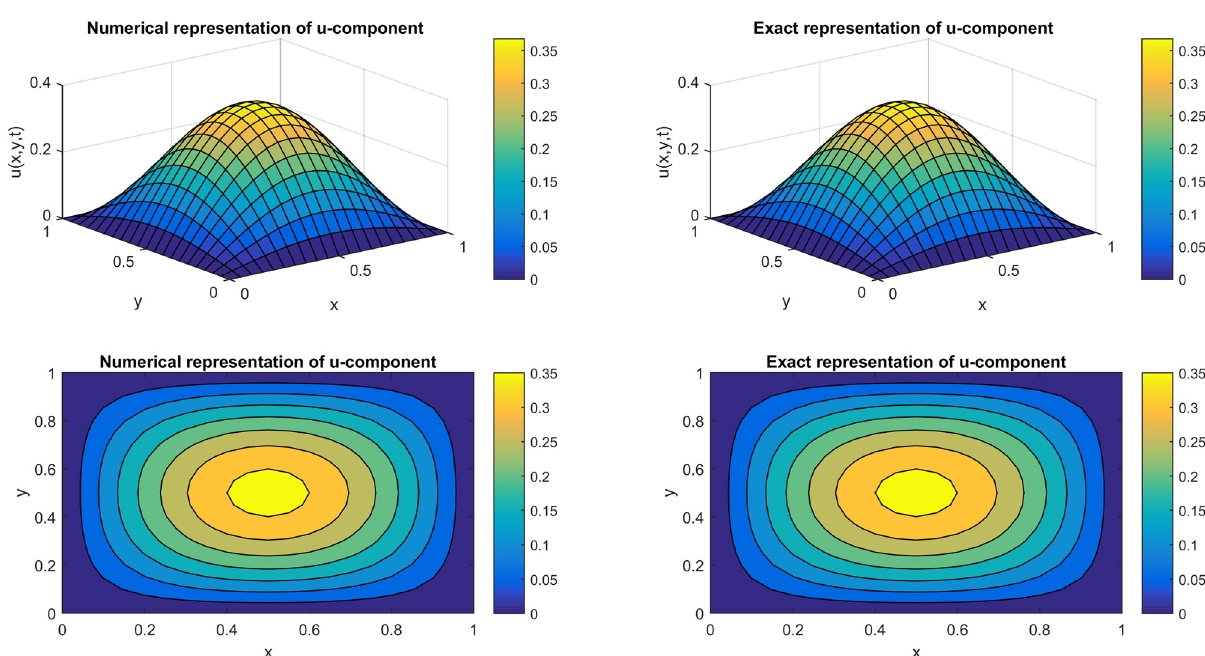
Figure 17: Surface and contour plots for u component at t = 1 for = N 21 , = α 1 , = β 1 , = t Δ 0.0001 , and = τ 0.5 using Method I regarding Example